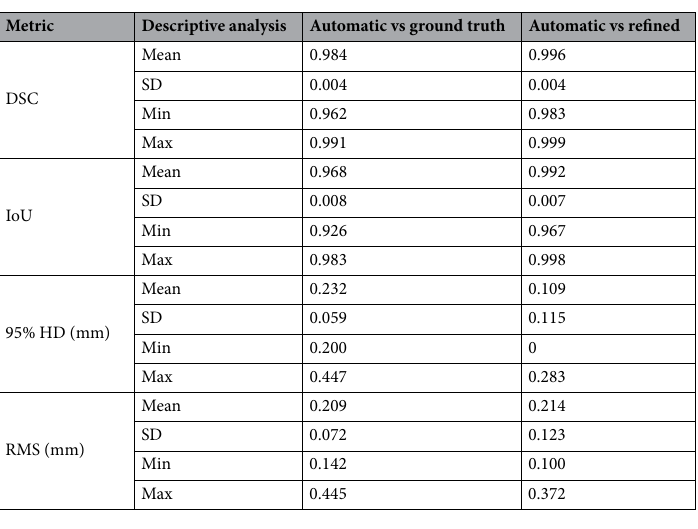
Table 3. Accuracy assessment of automatic segmentation. DSC dice similarity coefficient, IoU intersection over union, HD hausdorff distance, RMS root mean square, SD standard deviation, Min minimal value, Max maximal value.